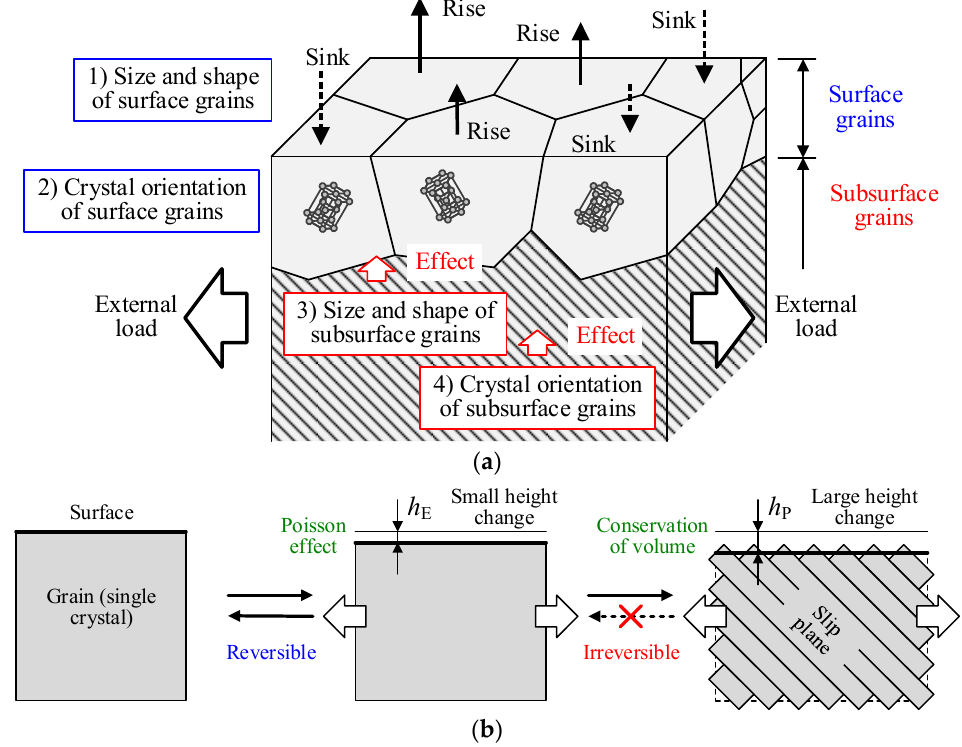
Figure 10. Height change of surface grains as a result of elastic and plastic deformation. ( a ) Rise and sink of surface grains, and deformation of subsurface grains; and ( b ) elastic and plastic deformation of each grain [19].